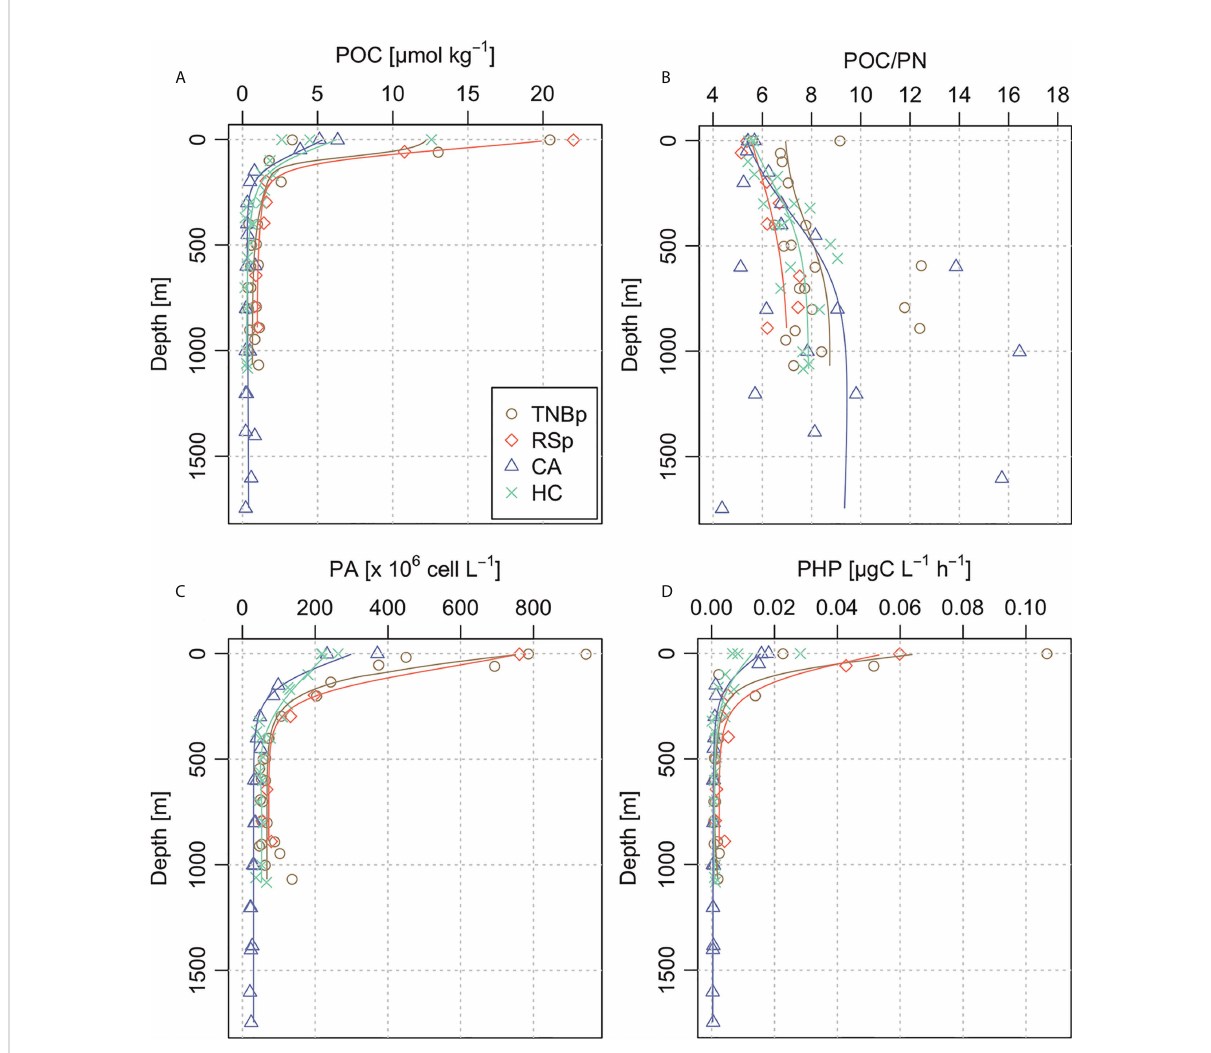
FIGURE 5 Bin-averaged pro fi les in the selected geographic areas of the Ross Sea (Terra Nova Bay polynya (TNBp), Ross Sea polynya (RSp), Hillary Canyon (HC), and Cape Adare (CA)) for (A) particulate organic carbon concentration (POC; m mol kg − 1 ), (B) molar ratio between particulate organic carbon and particulate nitrogen concentrations (POC/PN), (C) prokaryotic abundance (PA; cell L − 1 ), and (D) prokaryotic heterotrophic production (PHP; µgC L − 1 h − 1